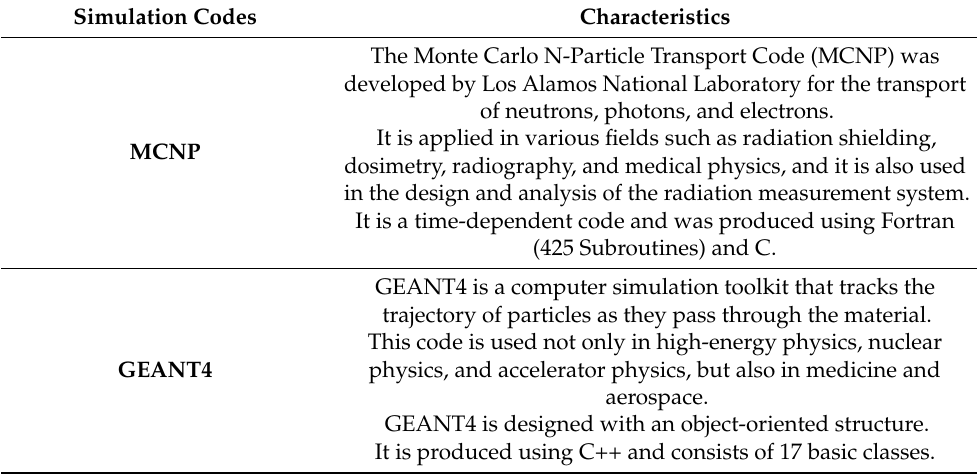
Table 2. Comparison of characteristics of MCNP and